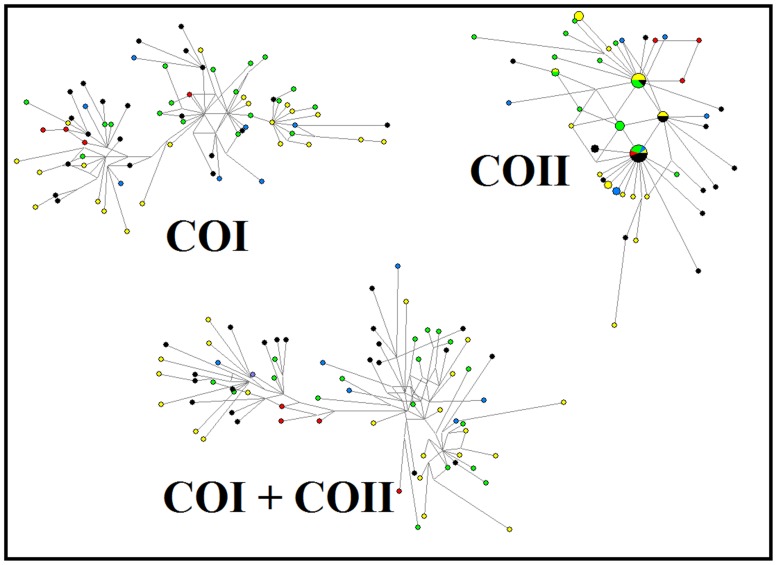
Median joining network of 71 taxa of the COI, COII, and COI+COII sequences from five different populations of Simulium tani in Cameron Highlands.Each haplotype is represented by a circle. Relative sizes of the circles indicate haplotype frequency. Circles of the same colour represent haplotypes from the same population (yellow = Elevation A, blue = Elevation B, green = Elevation C, red = Elevation D and black = Elevation E).